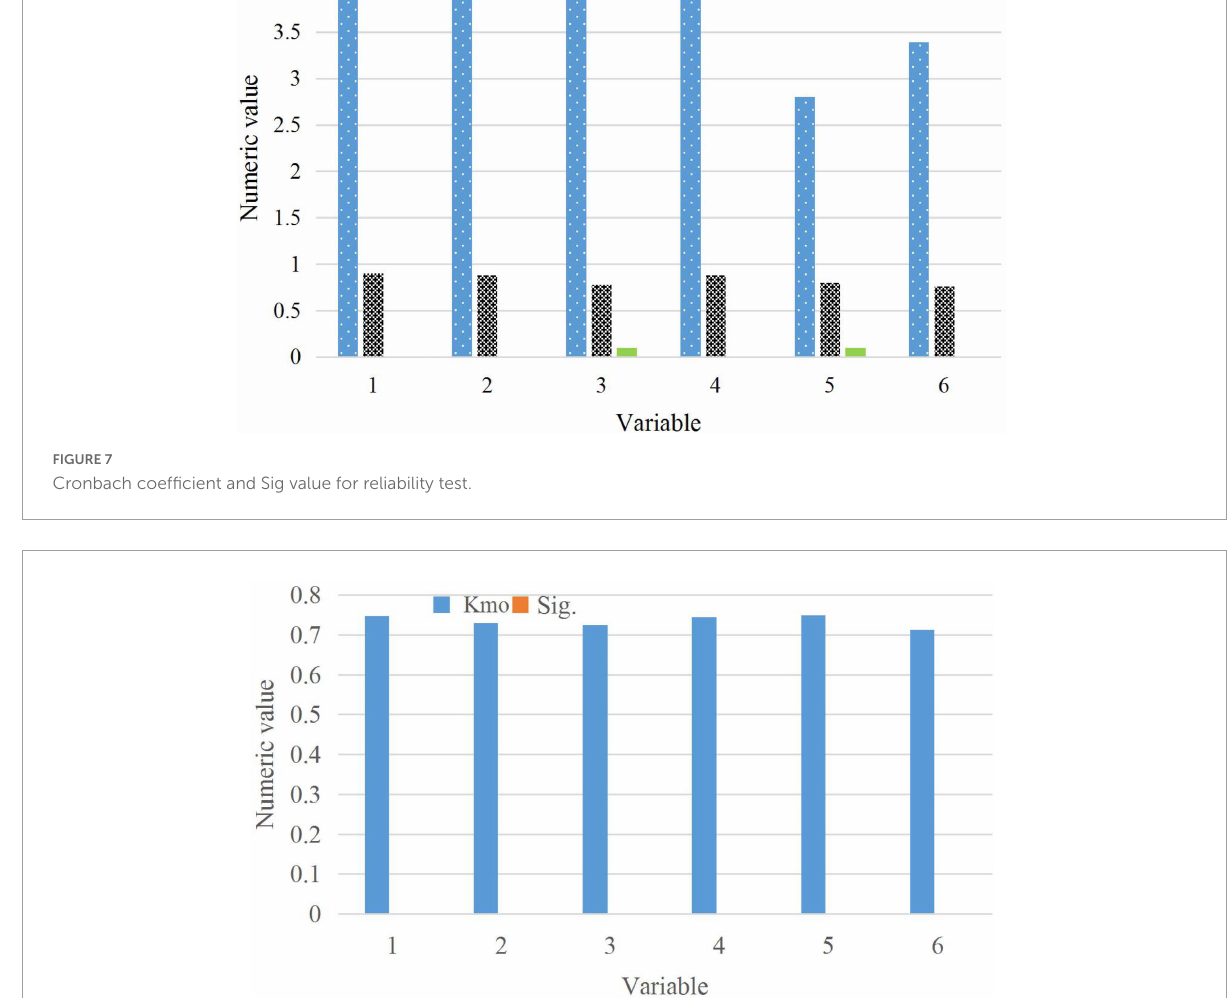
FIGURE8 Statistical results of Kaiser-Meyer-Olkin (KMO) value and Bartlett’s spherical